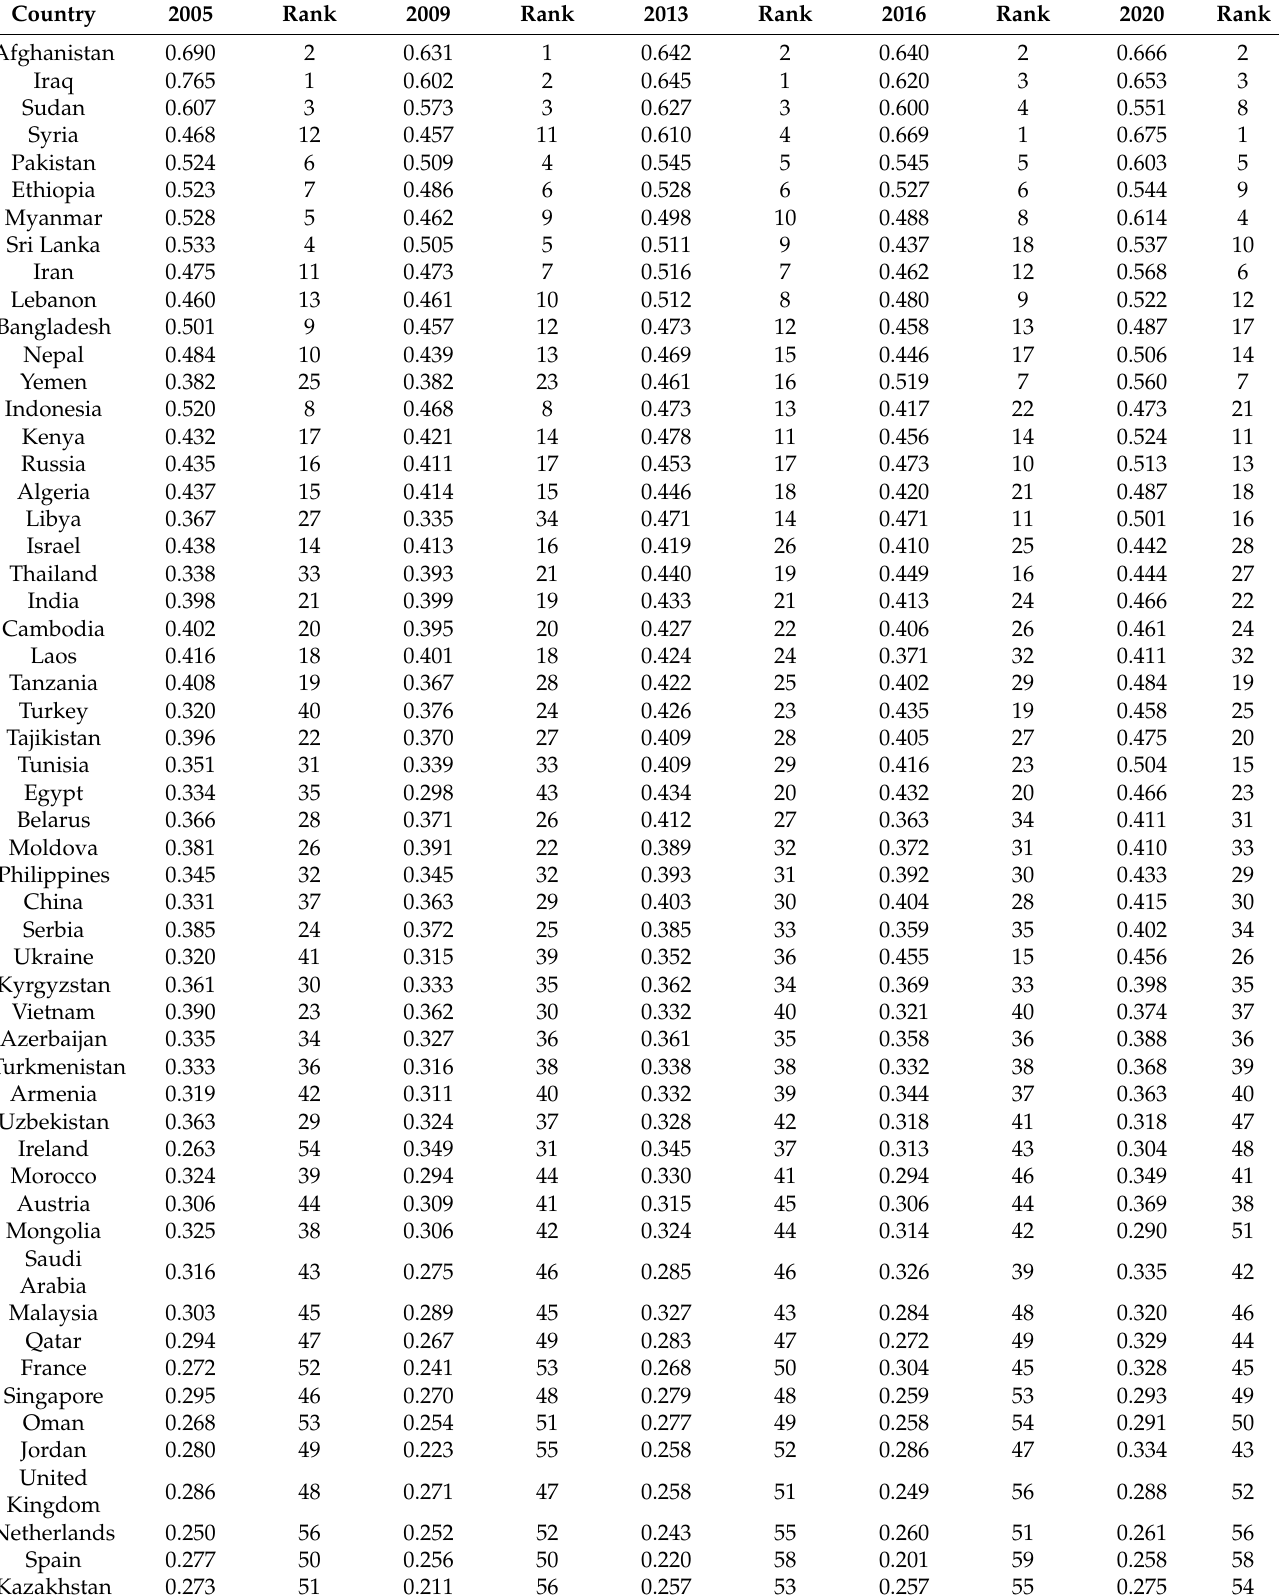
Table 2. Evolution of geopolitical risk level of countries along the Belt and